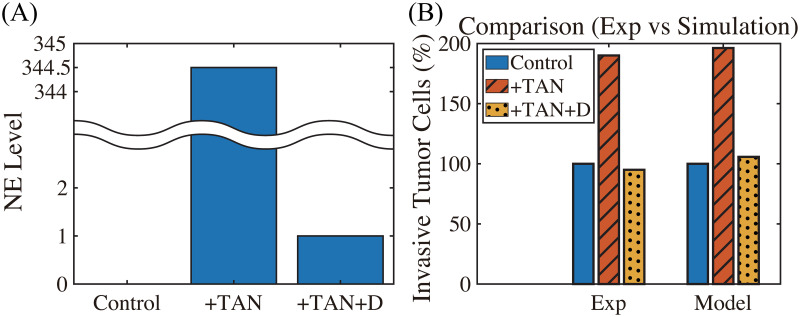
DNase I treatment against NE can abrogate the invasion-boosting effects of neutrophils (Experimental data [22] and simulation results).(A) NE levels in the system in the absence (control) and presence (+TAN) of neutrophils, and DNase treatment (+TAN+D) cases at t = 22 h. (B) Experimental data from the invasion assay in [22] (left column; 4T1 cancer cells) and computational results from mathematical model (right column). The graph shows the (scaled; %) population of invasive tumor cells at t = 22 h in the absence (control; blue) and presence (+TAN; red shaded) of neutrophils, and DNase treatment (+TAN+D; yellow dotted) cases. Addition of DNase I reduces the number of invading tumor cells by almost 50%.